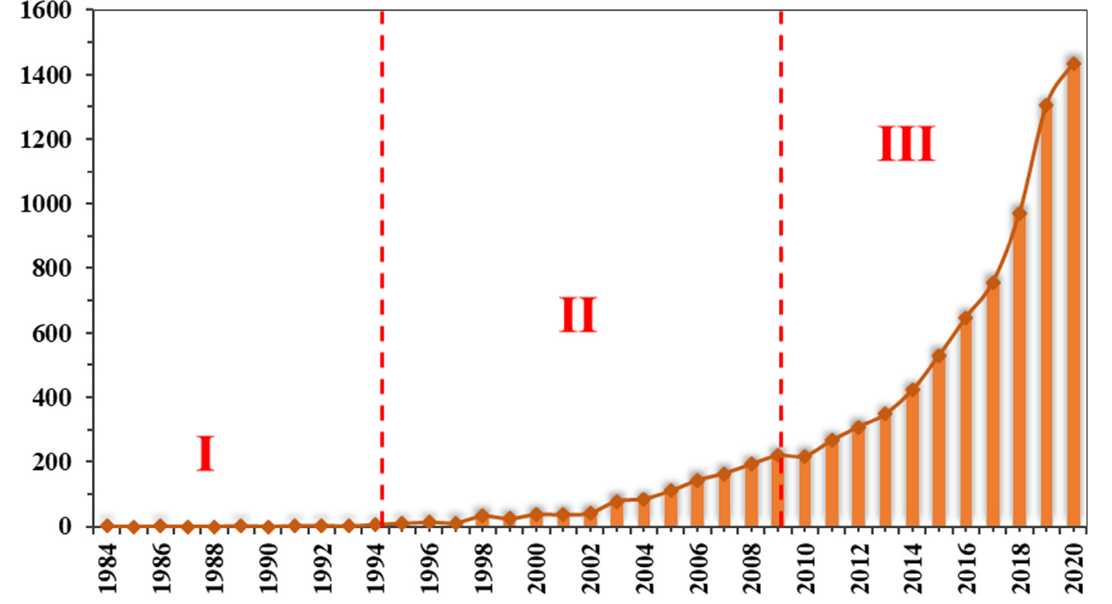
Figure 2. The number of papers published annually (until November 2020).